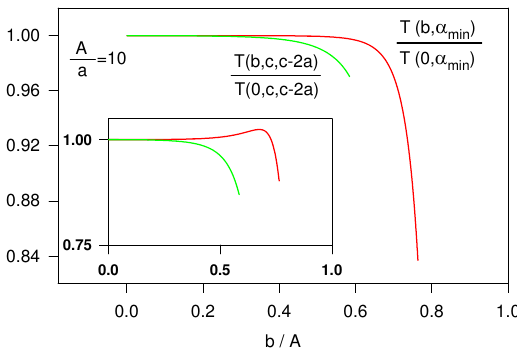
Figure 6: Ratios T ( b, α min ) /T (0 , α min ) (red curve) for c = ˜ c 1 ≃ 0 . 864 A and α = α min ≃ 0 . 232 rad and T ( b, cc − 2 a ) /T (0 , c, c − 2 a ) (green curve) for c = ˜ c 2 ≃ 0 . 885 A for the total torques per pole as functions of the ratio b/A for A/a = 10 .